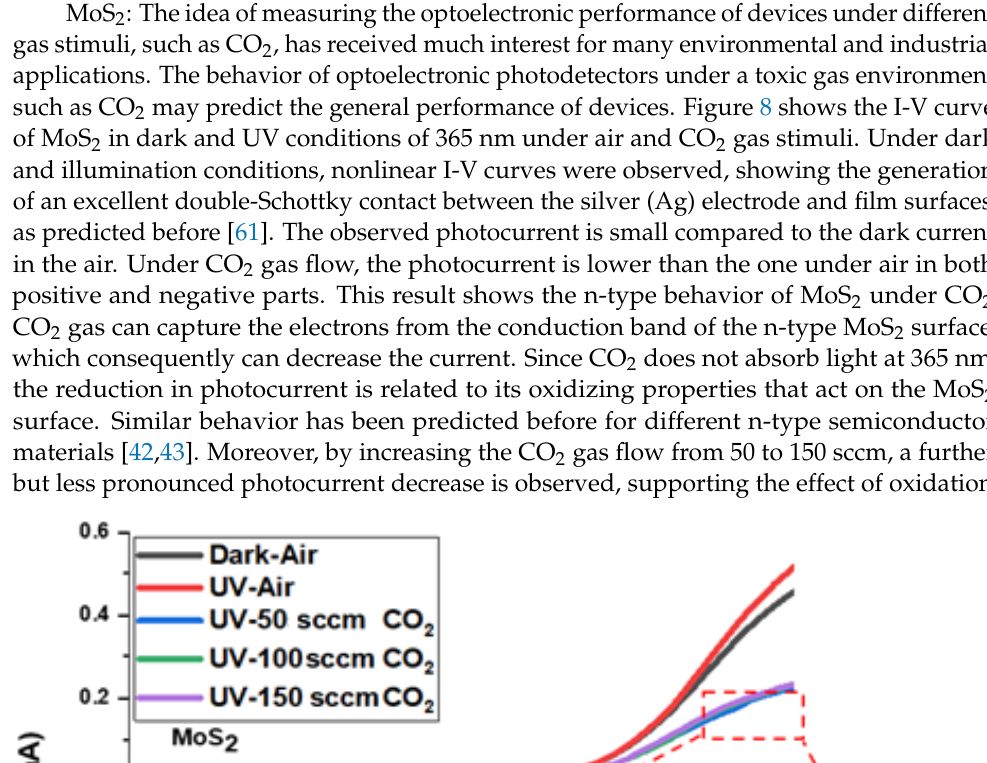
Figure 7. The MoS 2 and WS 2 photodetector under the illumination of UV light and the device’s actual image as seen through the probe station. The measurements were carried out in the air, O 2 , and CO 2 environments.